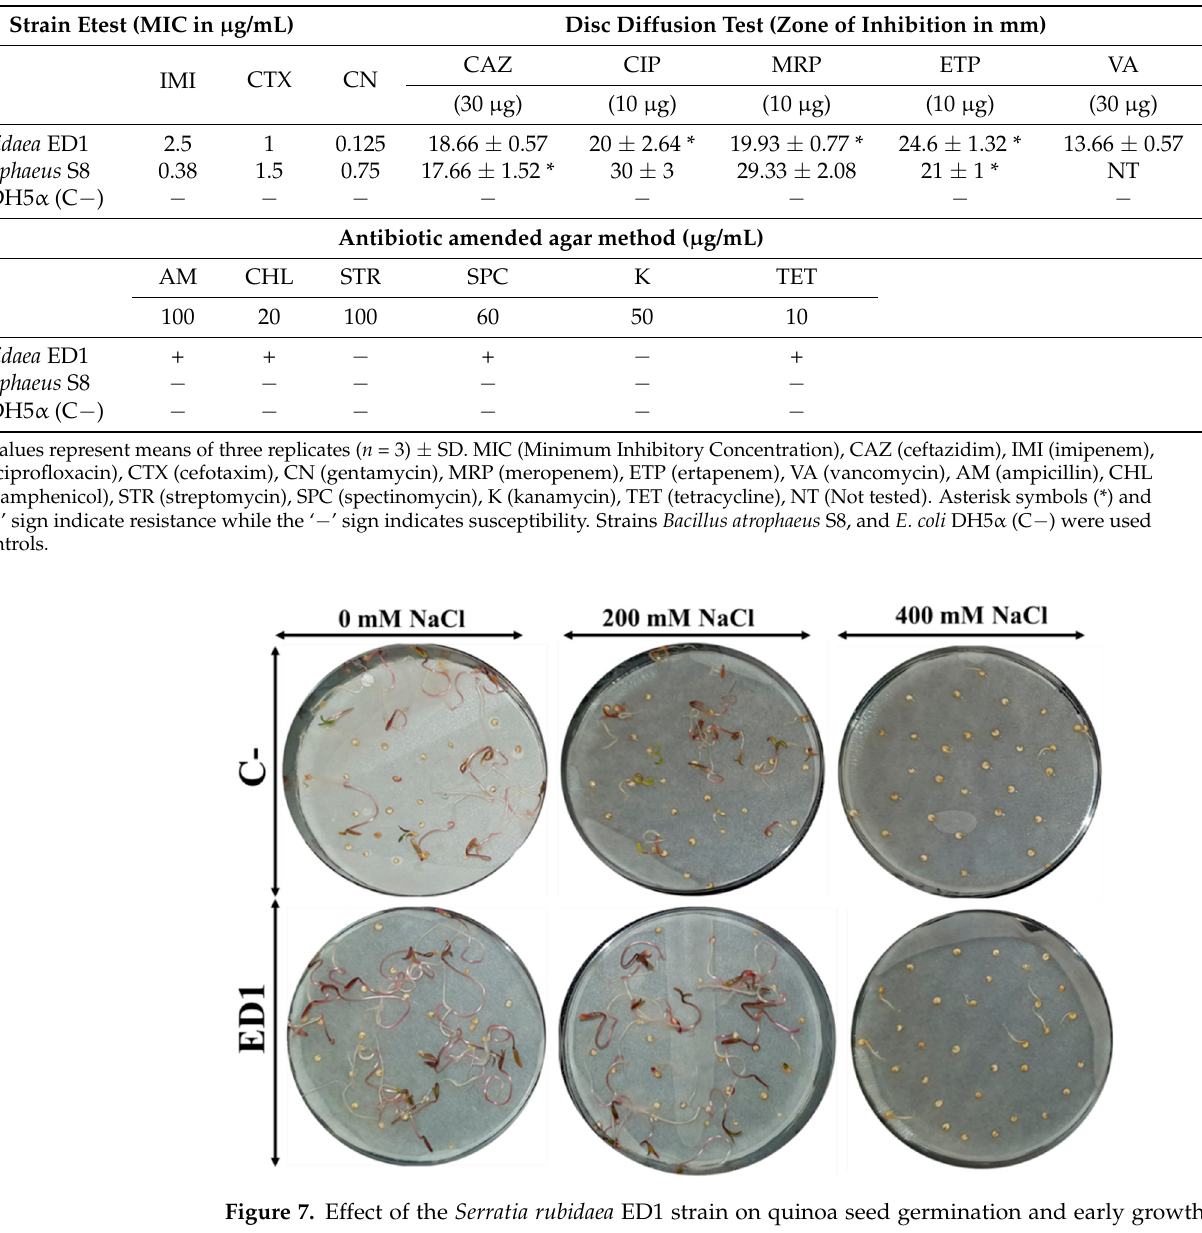
Table 4. Antibiotic resistance profile of the S. rubidaea ED1 strain using disc diffusion, Etest, and antibiotic amended agar methods.